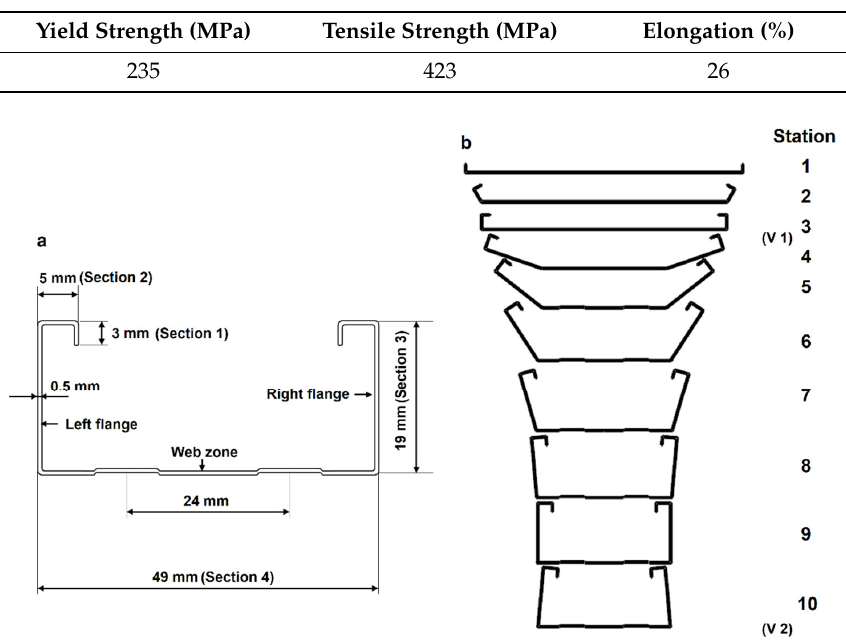
Table 2. Mechanical properties of Q235 steel.